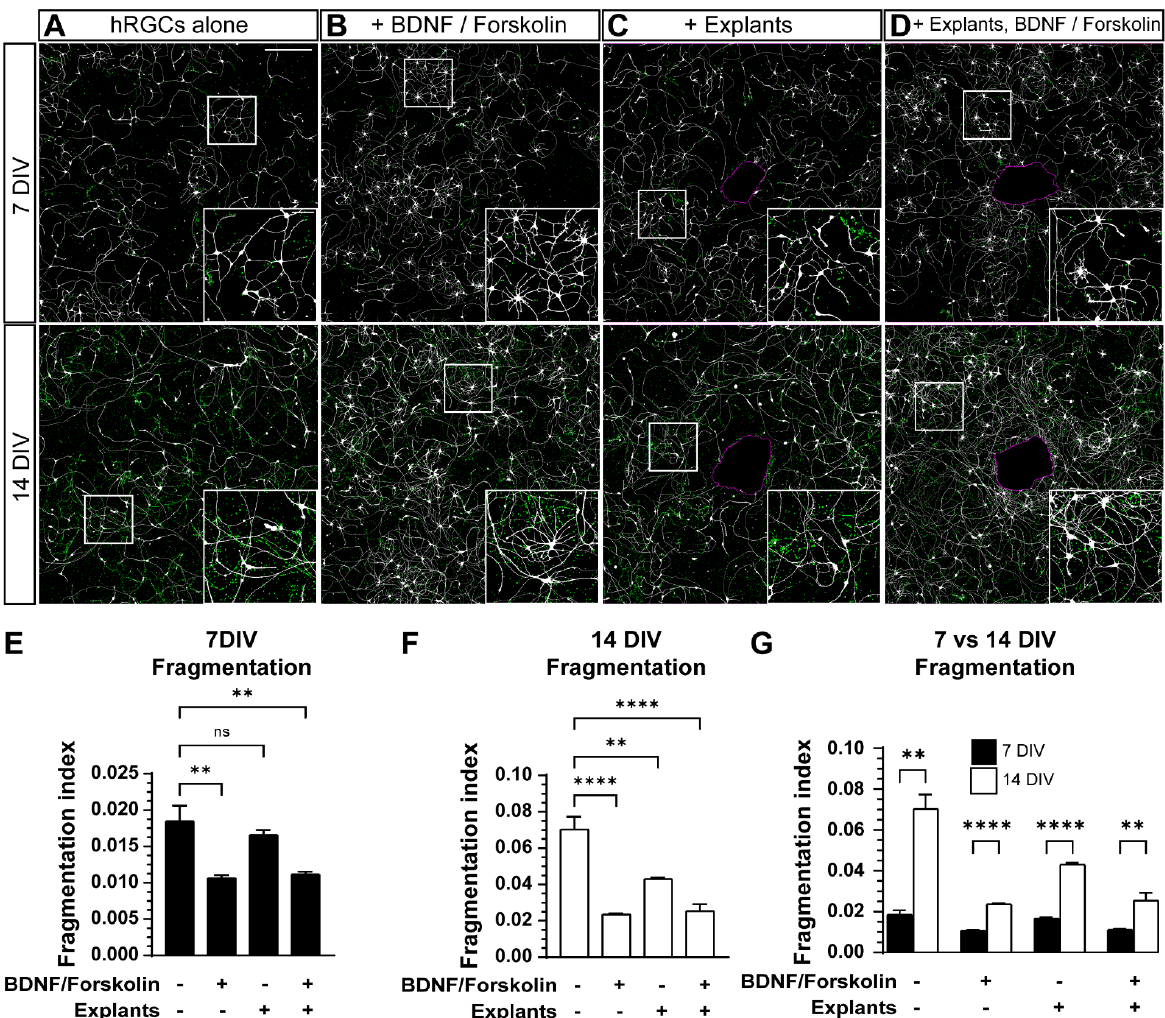
Figure 6. The effect of adult mouse retina explants and a combination of BDNF and forskolin on hRGC integrity. ( A – D ) Representative images of 7 DIV (top panels) and 14 DIV (bottom panels) hRGCs and their fragments, digitally dilated and colorized in green for ease of visualization. hRGCs